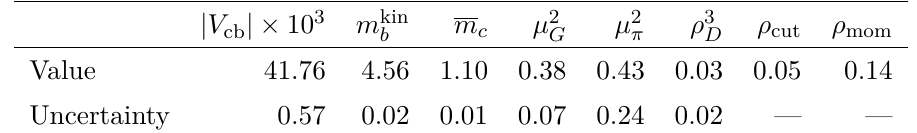
— — (1 GeV) , b and ρ . The O (1 /m 4 ) terms are set to zero. cut mom b